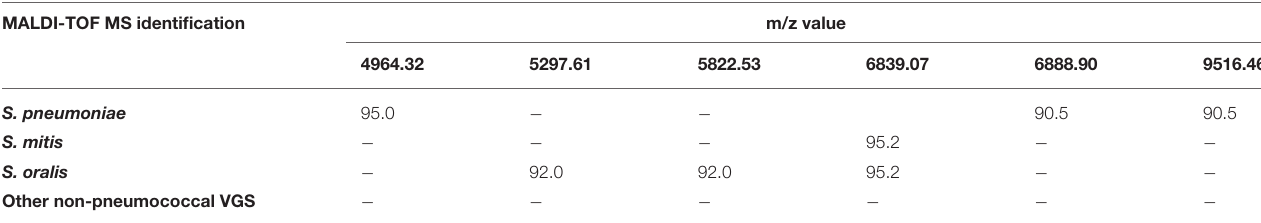
Other non-pneumococcal